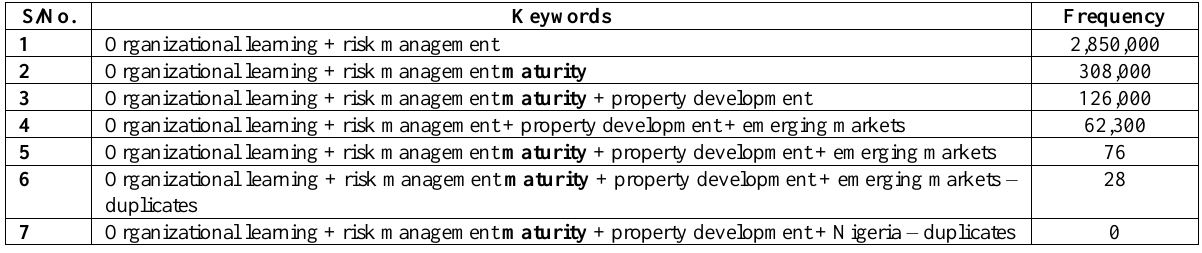
Table 1. PRISMA Results of Organizational Learning and Risk Management Maturity